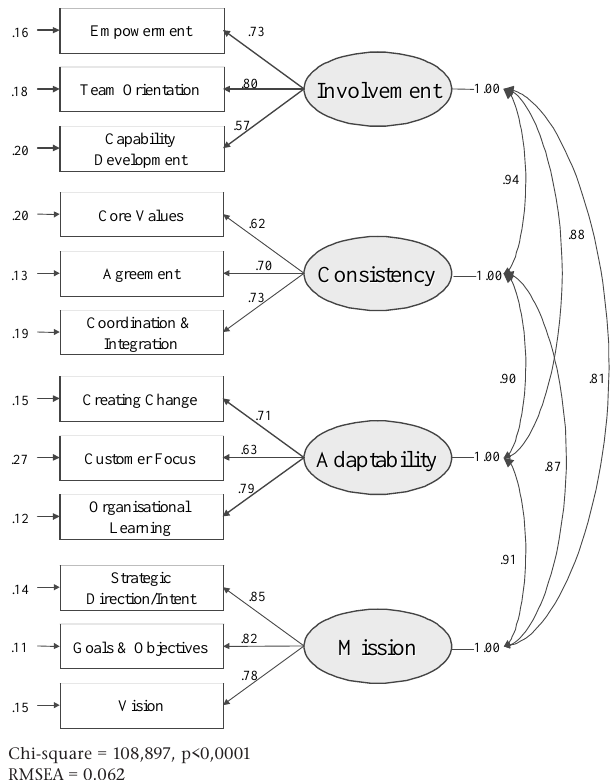
Figure 2. Path diagram of the hypothetical model showing the causal relations between the four organisational culture